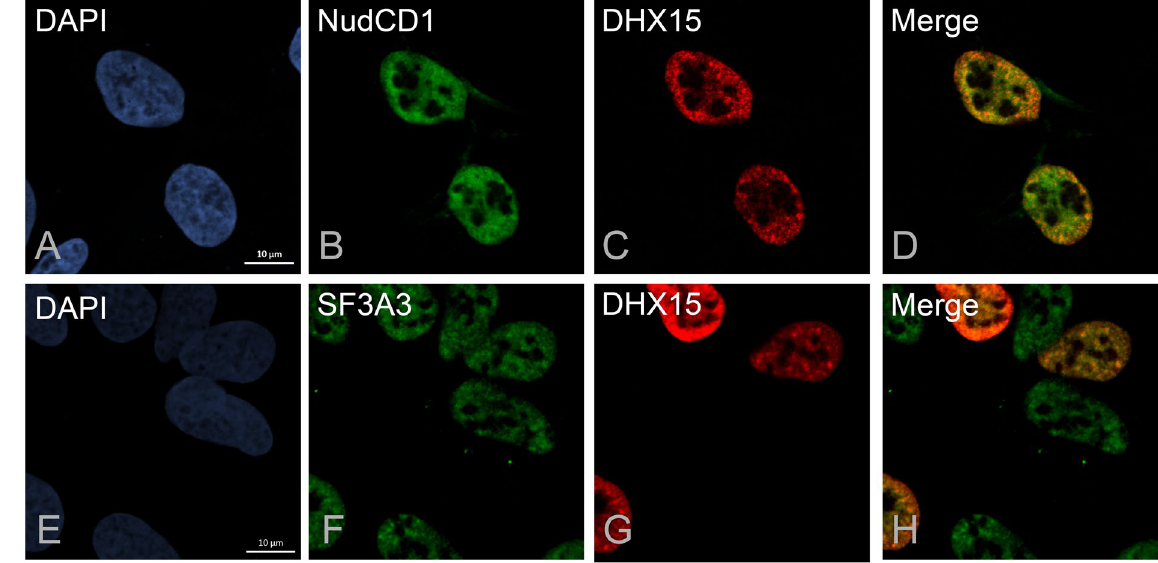
Figure 7. DHX15 colocalizes with SF3 proteins in nuclear speckles, but not NudCD1. U2OS cells transfected with Myc-DHX15 and NudCD1-GFP constructions were fixed and revealed with GFP and Myc antibodies (Fig. 7A–D). To confirm that the localization pattern of DHX15 was consistent with splicing speckles, we also performed immunofluorescence experiments on DHX15 and one of the identified splicing factor, SF3A3 (Fig. 7E–H). The nucleus were stained with